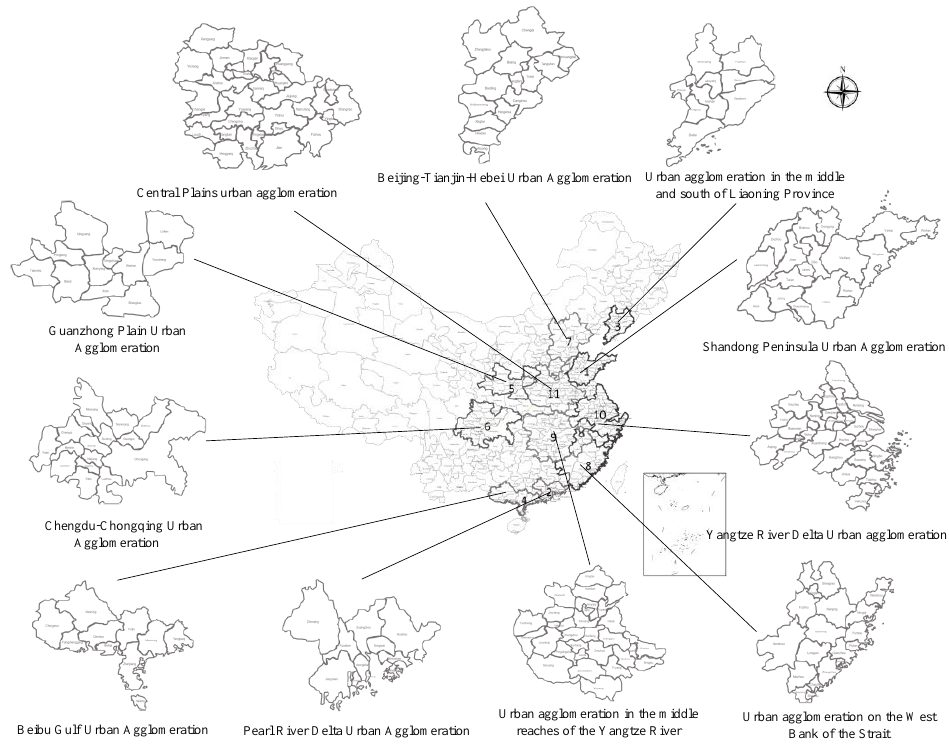
Figure 1. The distribution of 11 urban agglomerations in China.